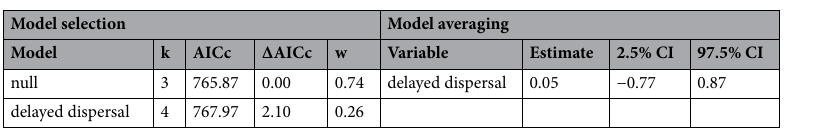
Table 2. Models obtained to assess differences in lifetime productivity of urban burrowing owls Athene cunicularia delaying dispersal and forming family units or breeding during their first year. Estimates and 95% confidence intervals (2.5% and 97.5%) were assessed after model averaging. Models were corrected for zero-inflation. k: number of parameters, AICc: Akaike Information Criterion corrected for small sample sizes, ΔAICc: the difference between the AICc of model i and that of the best model (i.e. the model with the lowest AICc), w: Akaike weights. The fit of the model including all variables used in model averaging can be checked in Fig.